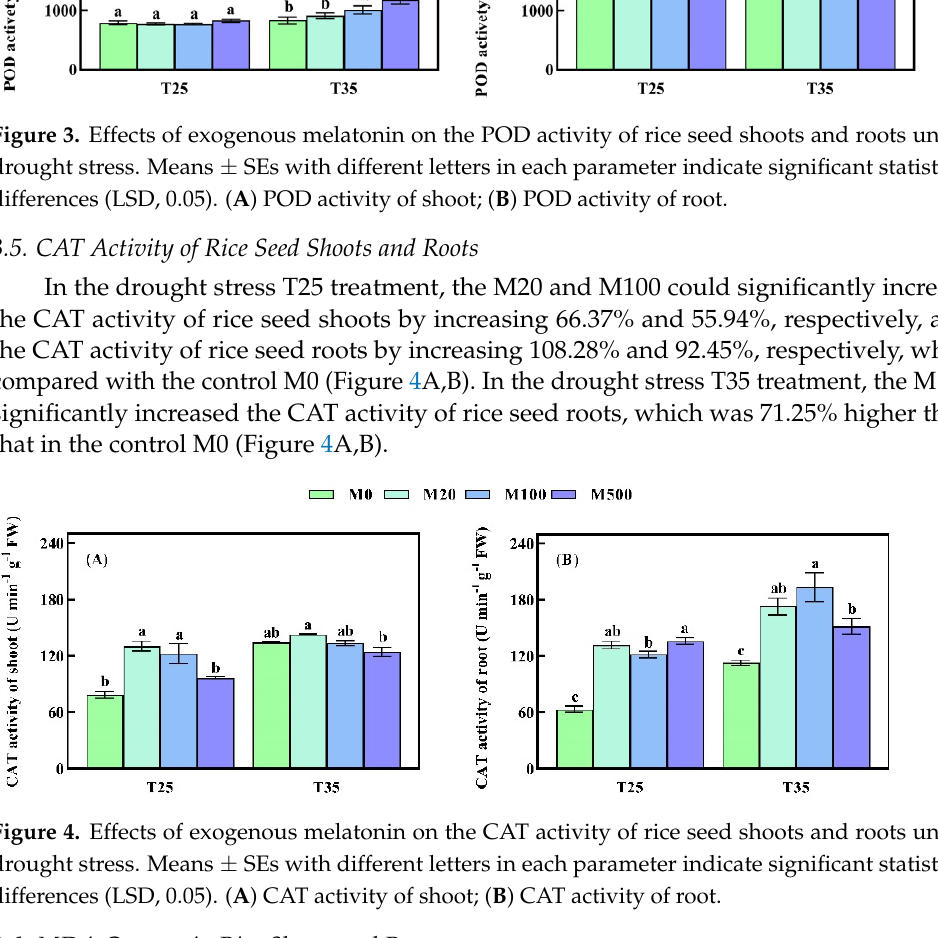
Figure 5. Effects of exogenous melatonin on MDA content in rice shoots and roots under drought stress. Means ± SEs with different letters in each parameter indicate significant statistical differences (LSD, 0.05). ( A ) MDA content of shoot; ( B ) MDA content of root. 3.7. Soluble Protein Content of Rice Seed Shoots and Roots In the drought stress T25 treatment, M20, M100, and M500 significantly increased the soluble protein content of rice seed shoots, which was 7.09~62.89% higher than that of the control M0. Melatonin at the M100 significantly increased the soluble protein content of rice roots, which was 35.49% higher than that of the control M0 (Figure 6A,B). In the drought stress T35 treatment, the soluble protein content of the roots of rice seeds treated with the M100 increased by 20.28% compared with the control M0 (Figure 6A,B).